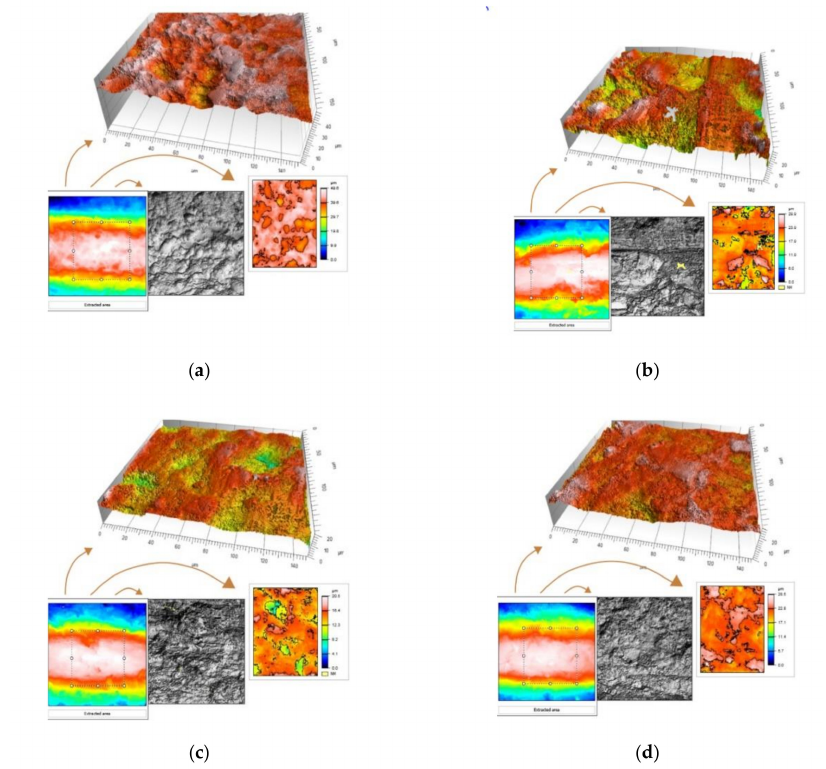
Figure 5. A topographic map of a 160 × 160 µ m area at the highest point of the first cervical microthread that was obtained using Nanofocus µ surf explorer after photostimulation. The implant topography is presented on a unique color spectrum representing the range of surface height. ( a ) control group implant; ( b ) D3.65 group implant; ( c ) D3.2 group implant; ( d ) D2.8 group implant. The scan was performed with a 160 s lens using × 100 magnification.